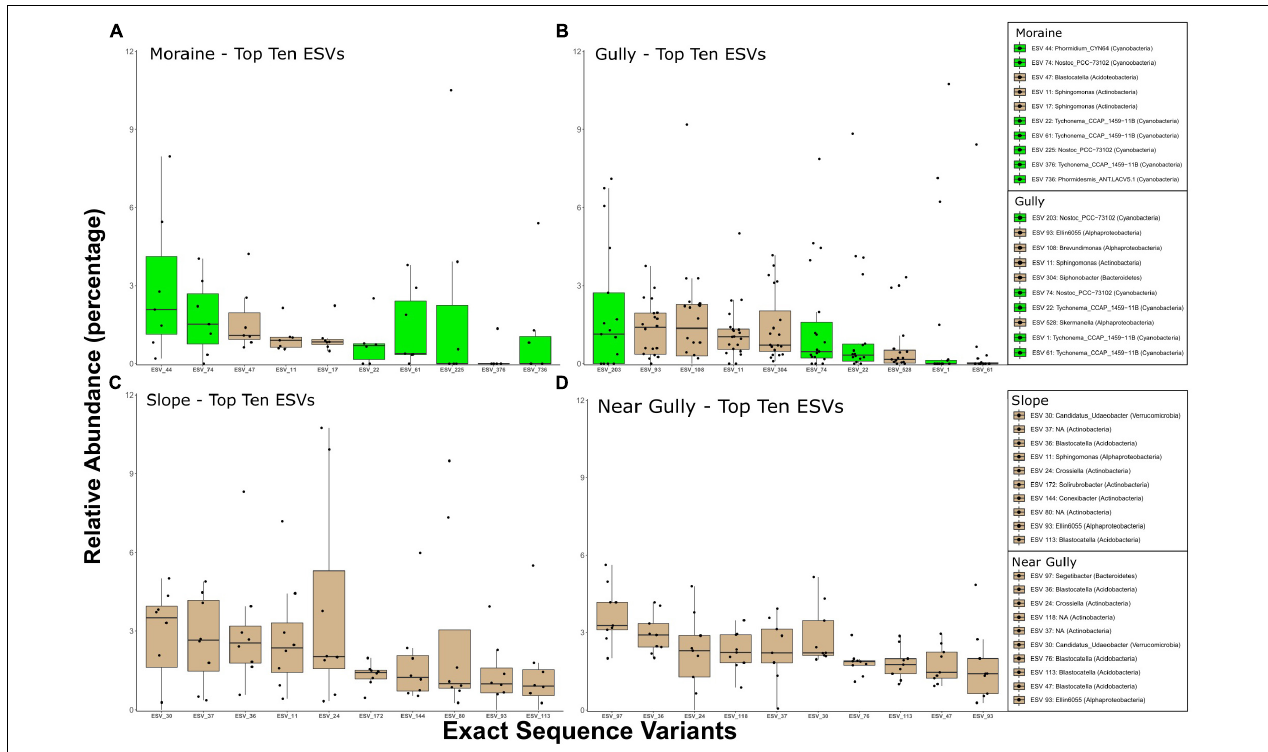
FIGURE 6 | Top 10 16S ESVs from each habitat. (A) moraine, (B) gully, (C) slope, and (D) near gully. Boxplots are ordered by the median relative abundance of untransformed DNA-seq data and colored according to inferred energy-carbon acquisition-photoautotrophs (green) and chemoheterotrophs